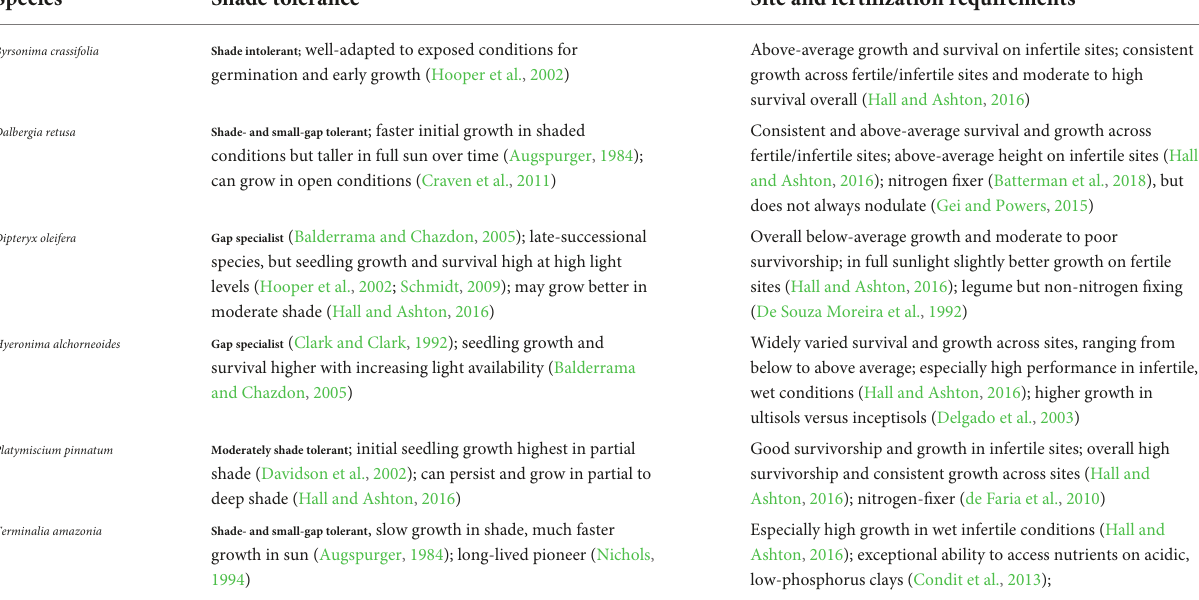
TABLE 3 Shade tolerance and site and fertilization requirements for each of the six study species, based on the pre-existing literature. Species Shade tolerance Site and fertilization requirements Above-average growth and survival on infertile sites; consistent Byrsonimacrassifolia Shadeintolerant; well-adapted to exposed conditions for germination and early growth (Hooper et al., 2002) growth across fertile/infertile sites and moderate to high survival overall (Hall and Ashton,